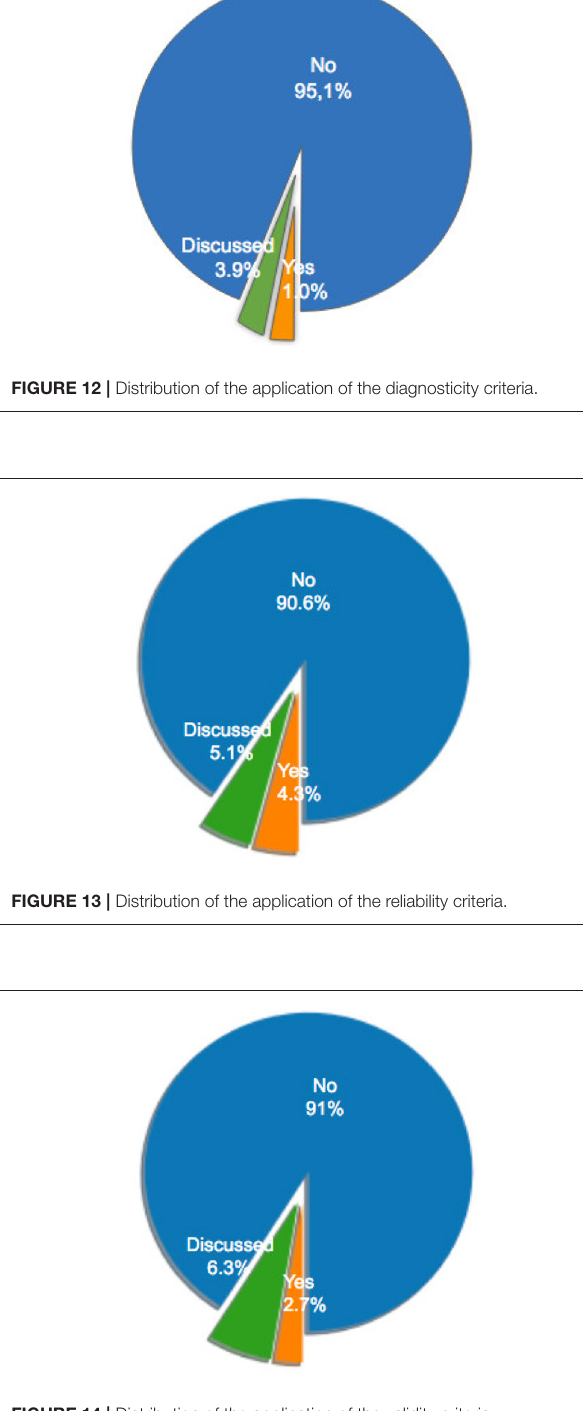
FIGURE 14 | Distribution of the application of the validity